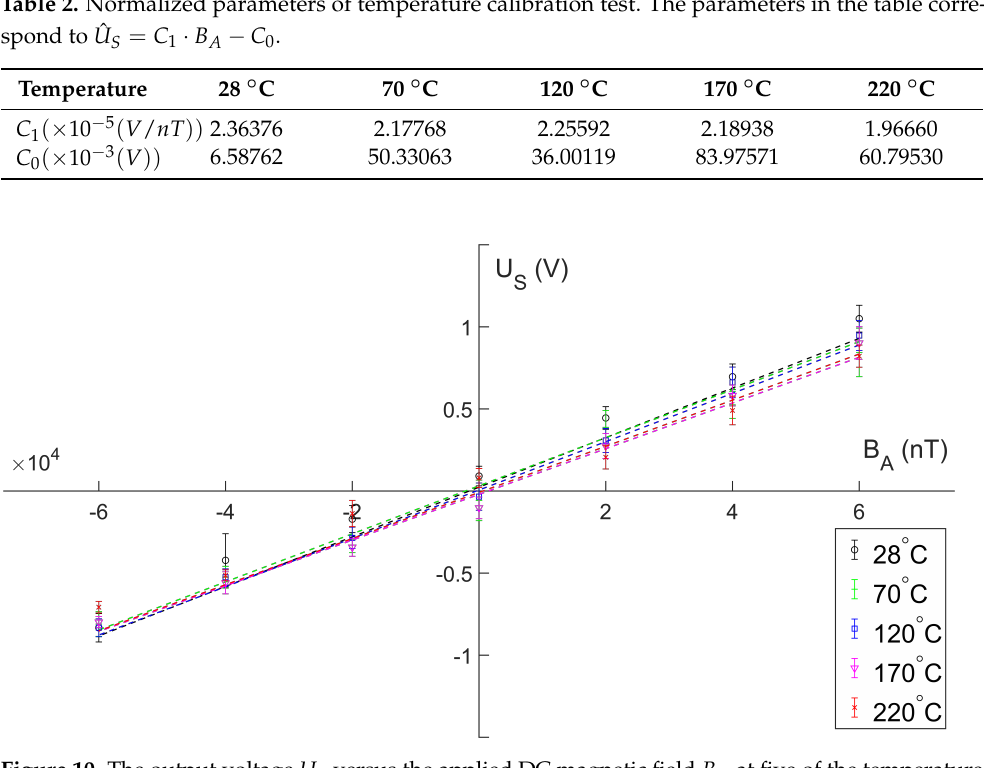
Figure 10. The output voltage U S versus the applied DC magnetic field B A at five of the temperature points. Data at different temperatures use different scatter markers and colors to be